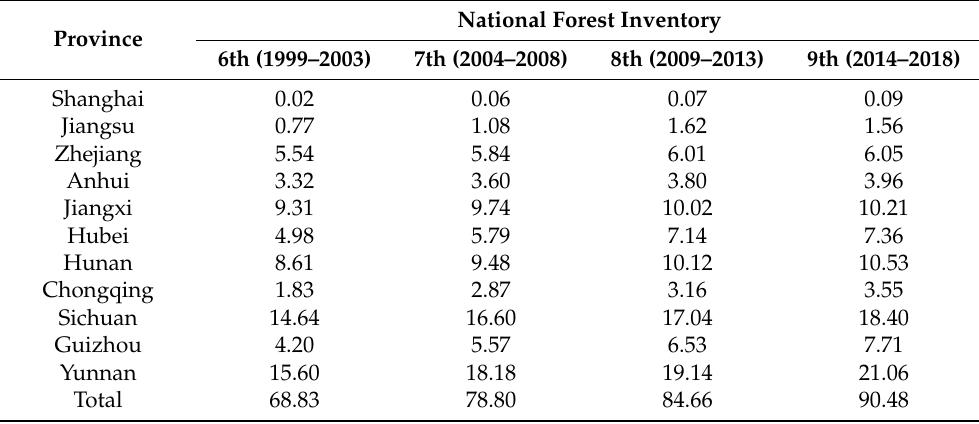
Table A1. Variation in the forest area of 11 provinces and municipalities in the Yangtze River Economic Belt based on the National Forest Inventory of China (10 6 hm 2